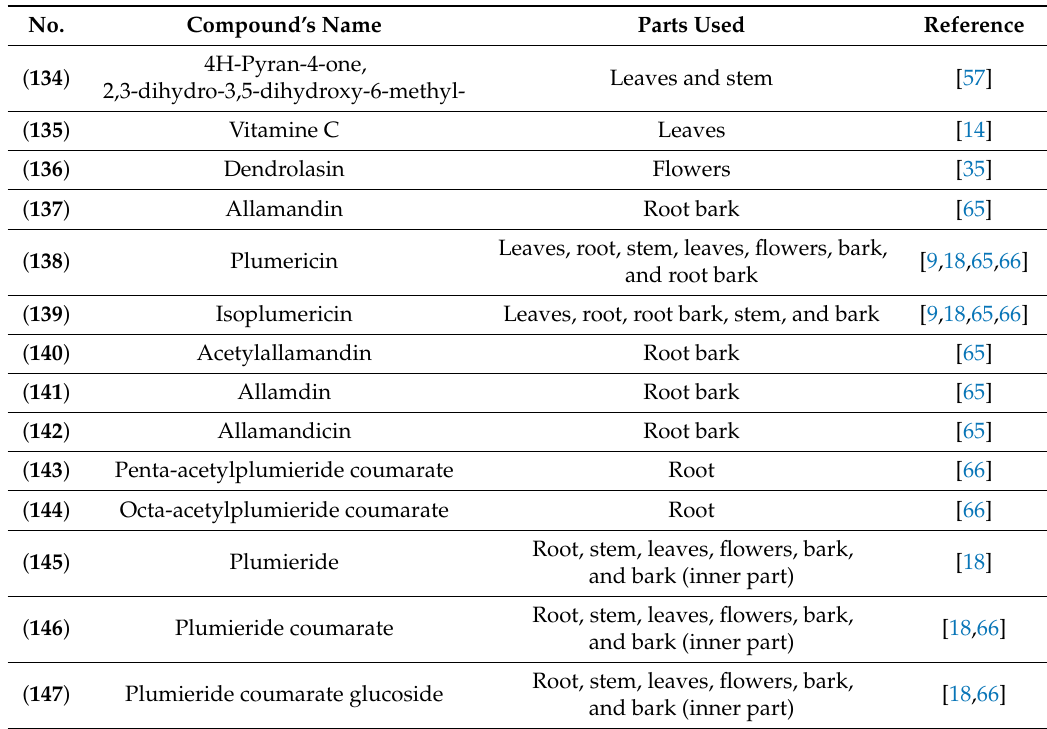
Table 8. The lactones from A. cathartica